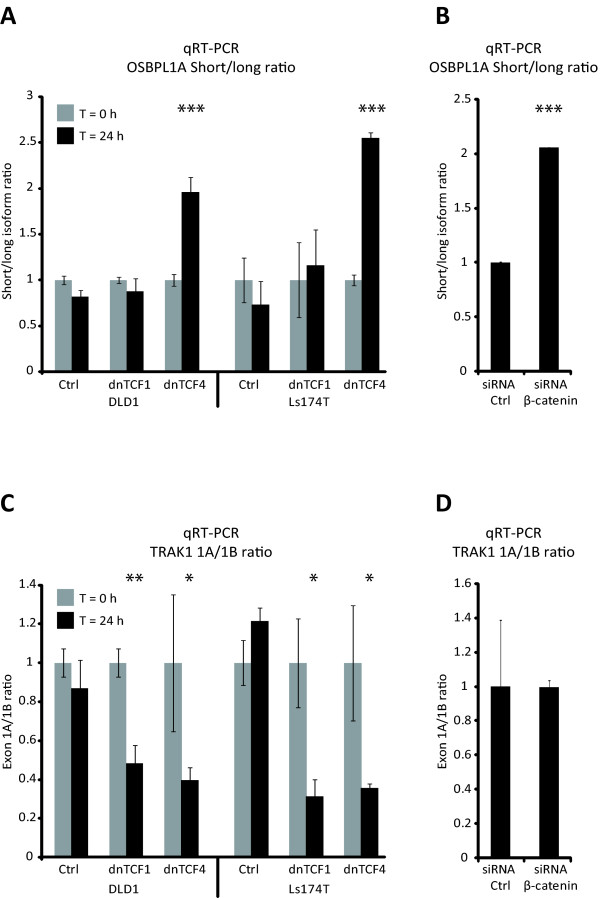
Wnt signaling regulates isoform expression of OSBPL1A and TRAK1. A, OSBPL1A isoform ratio measured by qRT-PCR in DLD1 and Ls174T cells expressing either dnTCF1 or dnTCF4 to disrupt the Wnt pathway. B, OSBPL1A isoform ratio in DLD1 cells transfected with either 20 nM control or β-catenin siRNA. C, TRAK1 exon 1A/1B ratio as described in A, D, TRAK1 exon 1A/1B ratio as described in B. * = p < 0.05, ** = p < 0.01 and *** = p < 0.001.